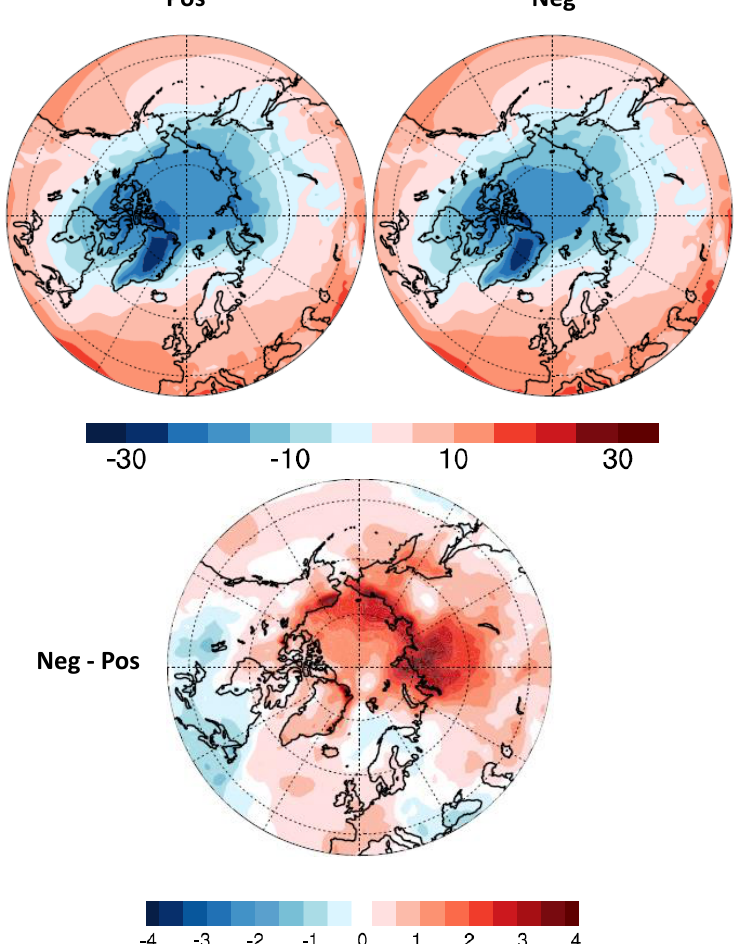
Fig. 11 SAT ( ° C, color) composites for Pos and Neg years for and Neg – Pos (Diff) changes Figure 11. SAT ( ◦ C, color) composites for Pos and Neg years for and Neg—Pos (Diff) changes during during spring from ERAinterim. spring from ERA